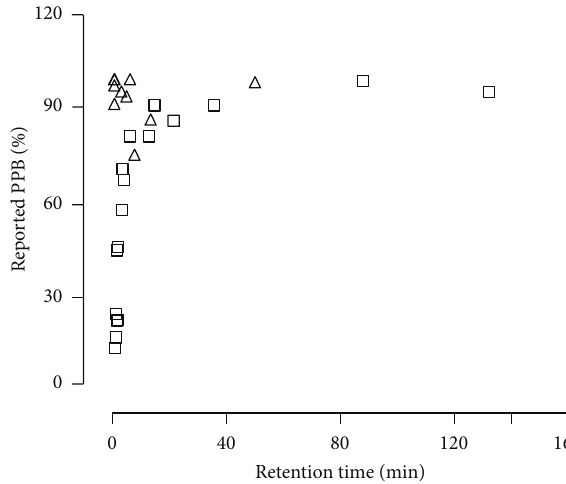
Figure 3: Scatter plot of retention time of reference compounds using immobilized HAS-HPLC and the corresponding reported PPB values. △ : compounds with pKa < 7.0; ◻ : compounds with pKa > 7.0.